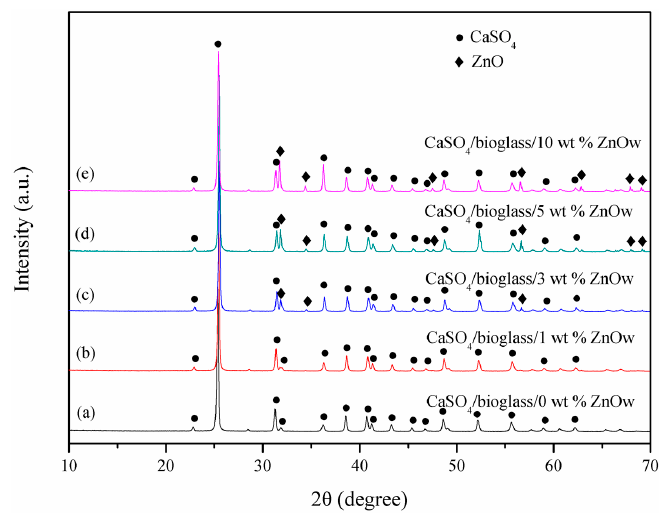
Figure 4. XRD spectra for the scaffolds with (a) 0 wt %; (b) 1 wt %; (c) 3 wt %; (d) 5 wt % and (e) 10 wt % ZnOw.